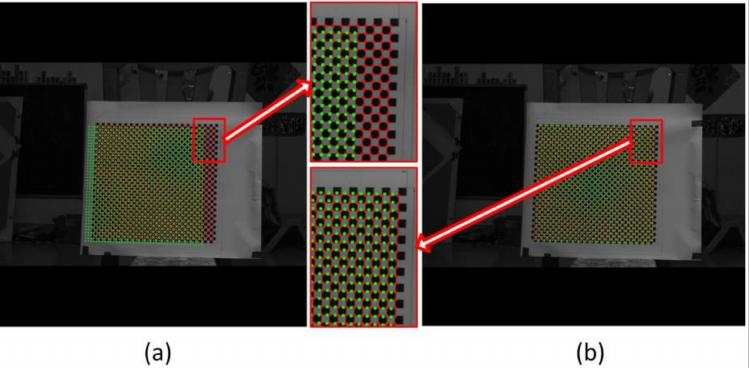
Figure 12. Corners after anamorphic ratio ( AR ) rectification. The red points indicate the corners in Figure 11a, and the green points indicate the corners in Figure 11b. ( a ) Image points in their original position, ( b ) green points shift their positions entirely, after which the two images almost overlap. This pixel decentering was due to the deviation between the optical axis and the axis of the rotary table.